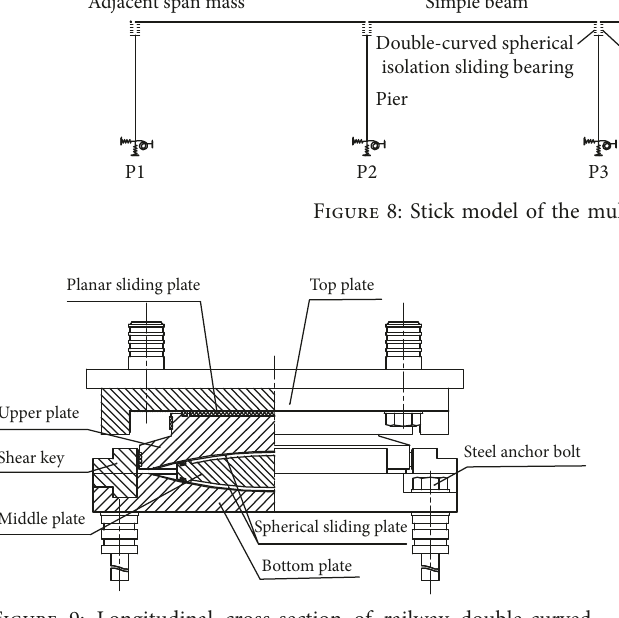
Figure 9: Longitudinal cross-section of railway double-curved spherical seismic isolation bearings.